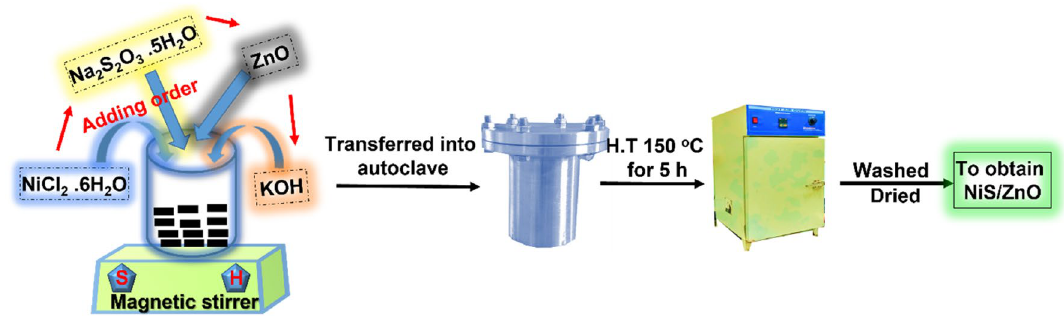
Figure 8. Fabrication of NiS/ZnO